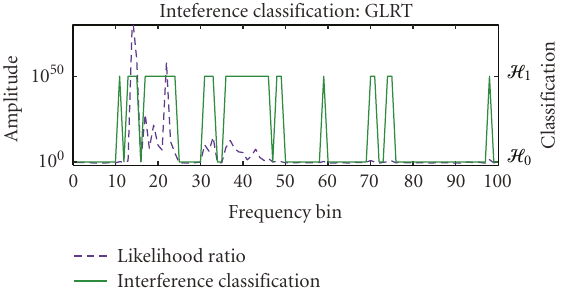
Figure 3: An example interference classification produced using the generalized likelihood ratio test on a per bin basis. The classification should be compared against reference sample vector interference spectrum shown in Figure 2. Several type I and type II errors can be seen.